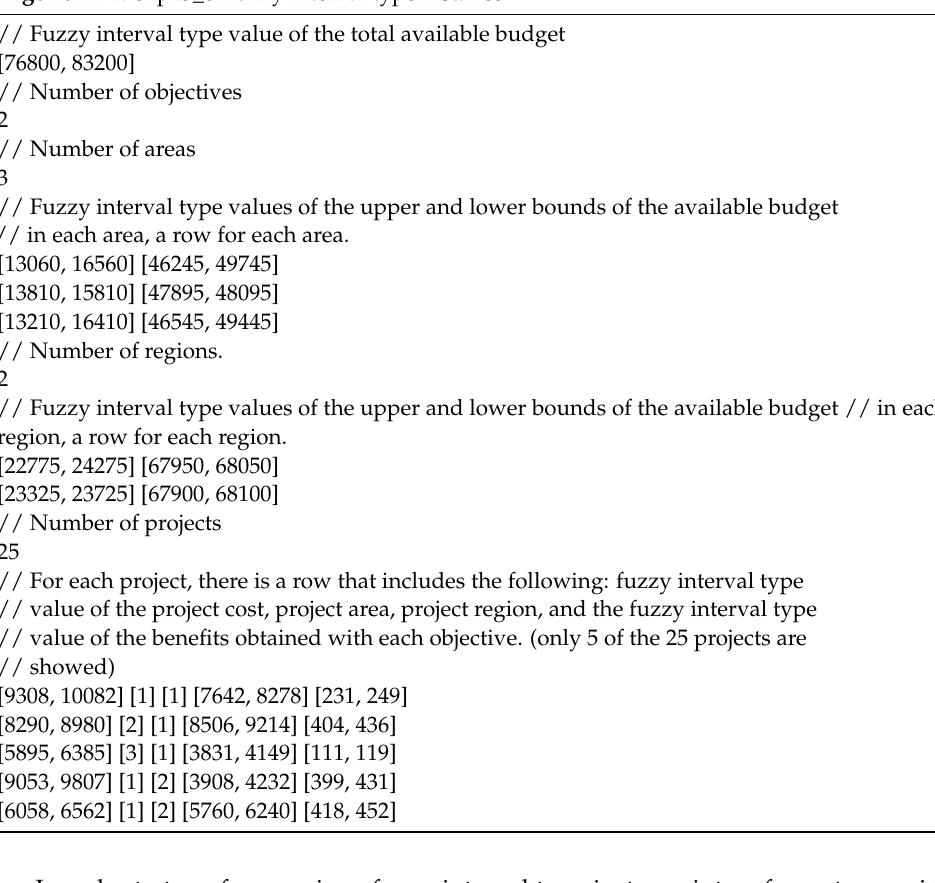
Algorithm 1. o2p25_0I fuzzy interval type